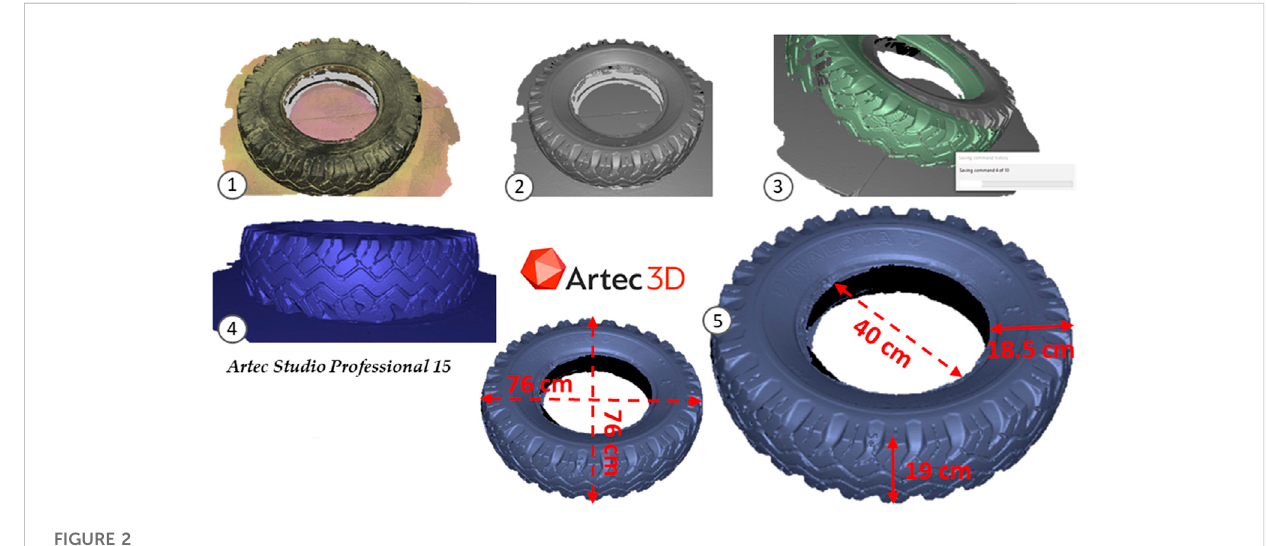
FIGURE 2 Processing of the scans in ArtecStudio Preofessional 15.